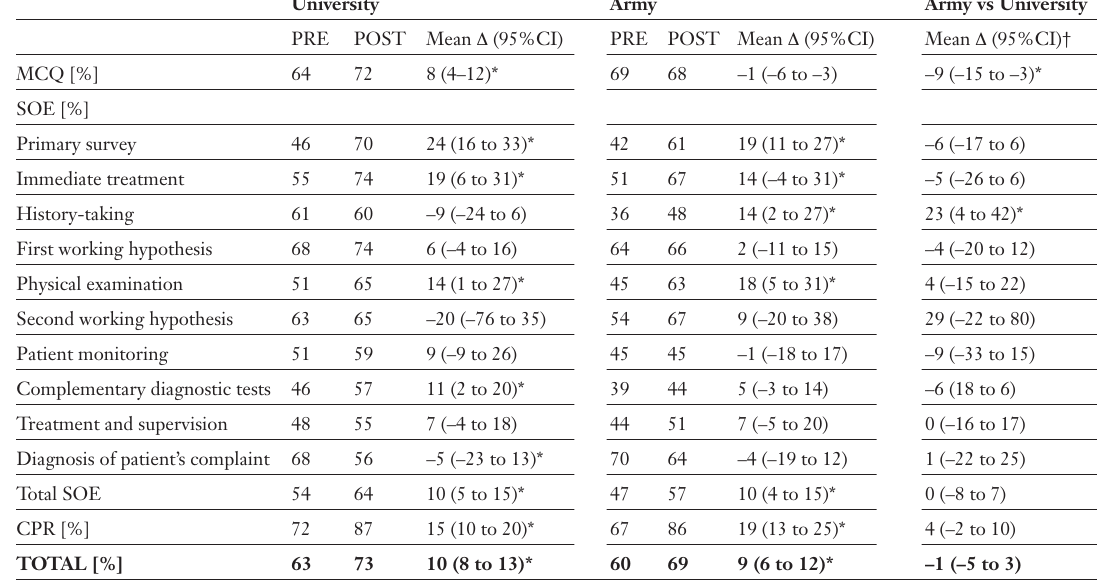
Overview of results of Multiple-choice questions (MCQ), Ob- jective Clinical Exam (SOE), and Cardio- Pulmonary resuscita- tion (CPR) examina-